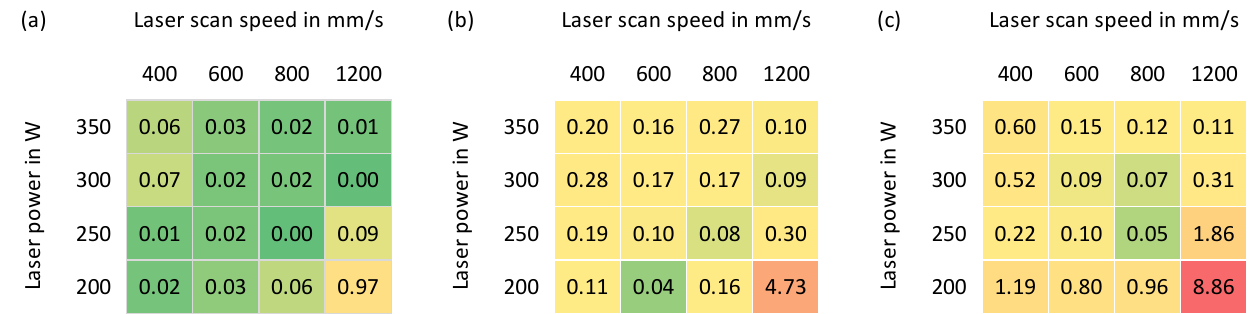
Figure 9. Porosity of the parts built with various process parameters: ( a ) X2CrNiMo17 ‐ 12 ‐ 2; ( b ) X2CrNiMoN25 ‐ 7 ‐ 4; ( c ) 50% X2CrNiMo17 ‐ 12 ‐ 2 + 50%X2CrNiMoN25 ‐ 7 ‐ 4.